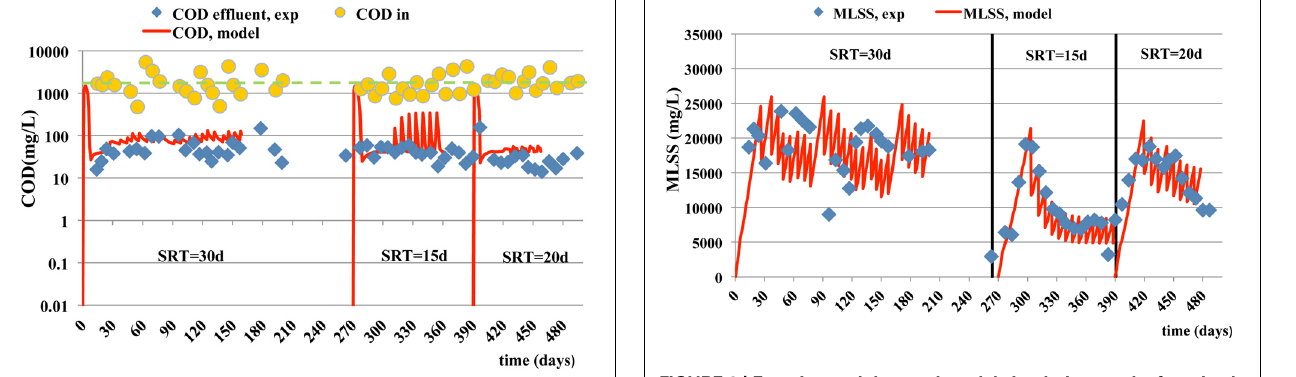
FIGURE 2 | Experimental data and model simulation results for mixed liquor suspended solids (MLSS).